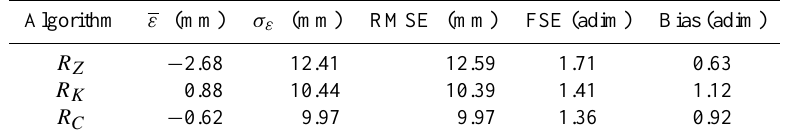
Table 2. Error scores computed on hourly cumulated rainfall for the event observed on 21 August 2013. RMSE refers to the root-mean-square error; FSE refers to the fractional standard error; “adim” represents adimensional ratios.